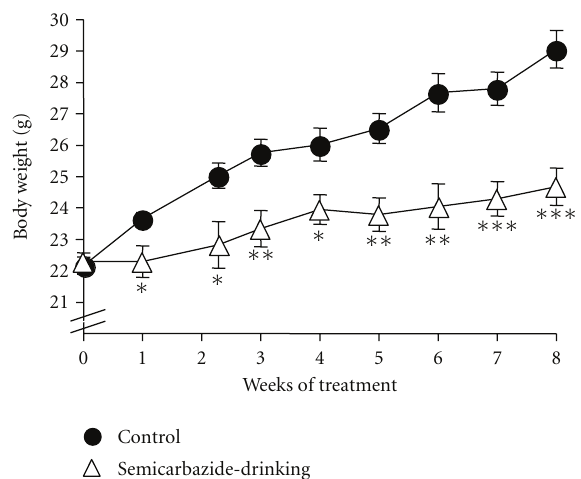
Figure 1: Body weight changes in mice treated or not with orally administered semicarbazide. Two groups of age- and weight- matched mice were constituted after weaning and before oral administration of semicarbazide (week 0), given at 125 mg/100 mL in drinking solution (semidrinking, open triangles), while control (black symbols) had free access to tap water. Mean ± SEM of 8 determinations. Di ff erent from corresponding control at ∗ P < . 05, ∗∗ P < . 01, ∗∗∗ P < . 001.